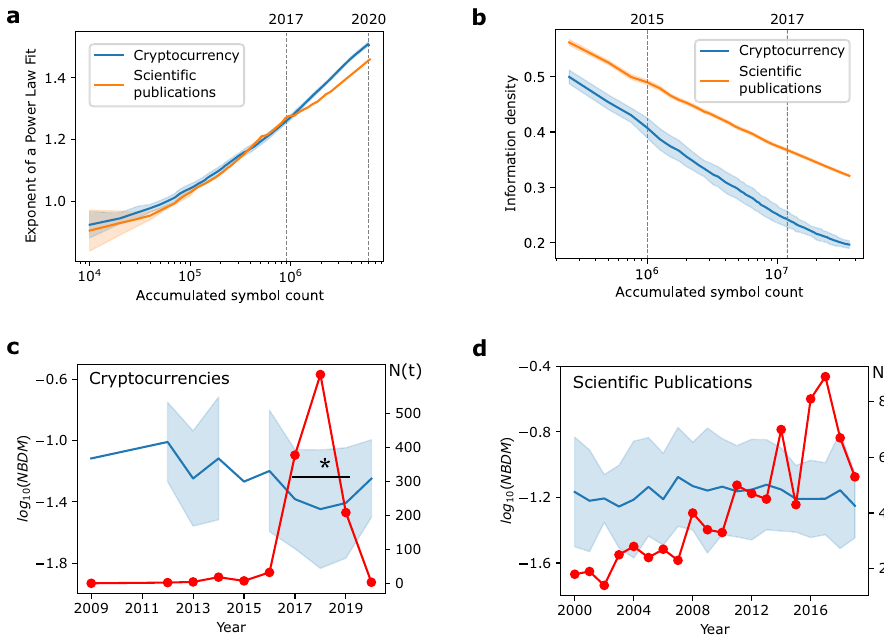
Fig. 6 Evolution of multi-scale diversity in the 2018 crash of cryptocurrencies. a Zipf's law exponent evolution for a given accumulated word count in cryptocurrency white papers (blue) and scienti fi c publications (orange). Solid line represents the average exponent of 25 replicate sub-samplings, and shaded region encompasses one standard deviation of this distribution. b Decay of information density for the accumulated number of symbols n ( t ) in cryptocurrency white papers (blue) and scienti fi c publications (orange). The solid line is the average information density of 25 replicates within-year orderings, while the shaded region represents one standard deviation of the distribution. The evolution of log-transformed size-normalized structural complexity (NBDM) in c cryptocurrency white papers and d scienti fi c publications. As a guide, the red line indicates the cultural product diversity N ( t ) in each domain for c and d . Asterisk-marked regions indicate statistically signi fi cant drops in complexity (see Supplementary Materials).